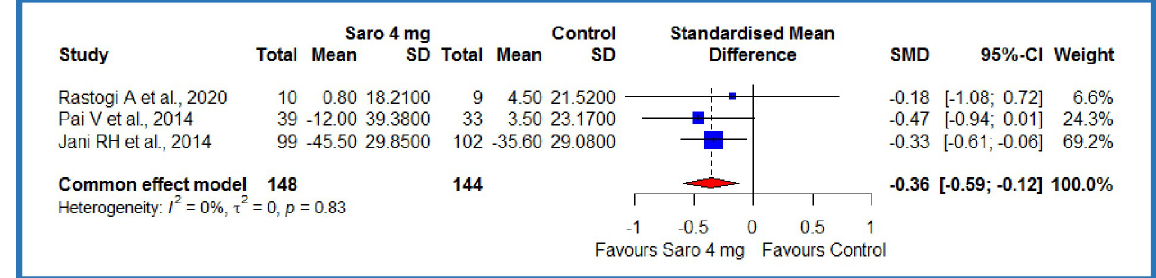
Fig 7. Forest plot of comparison of saroglitazar 4mg versus control on LDL-cholesterol (mg/dL).